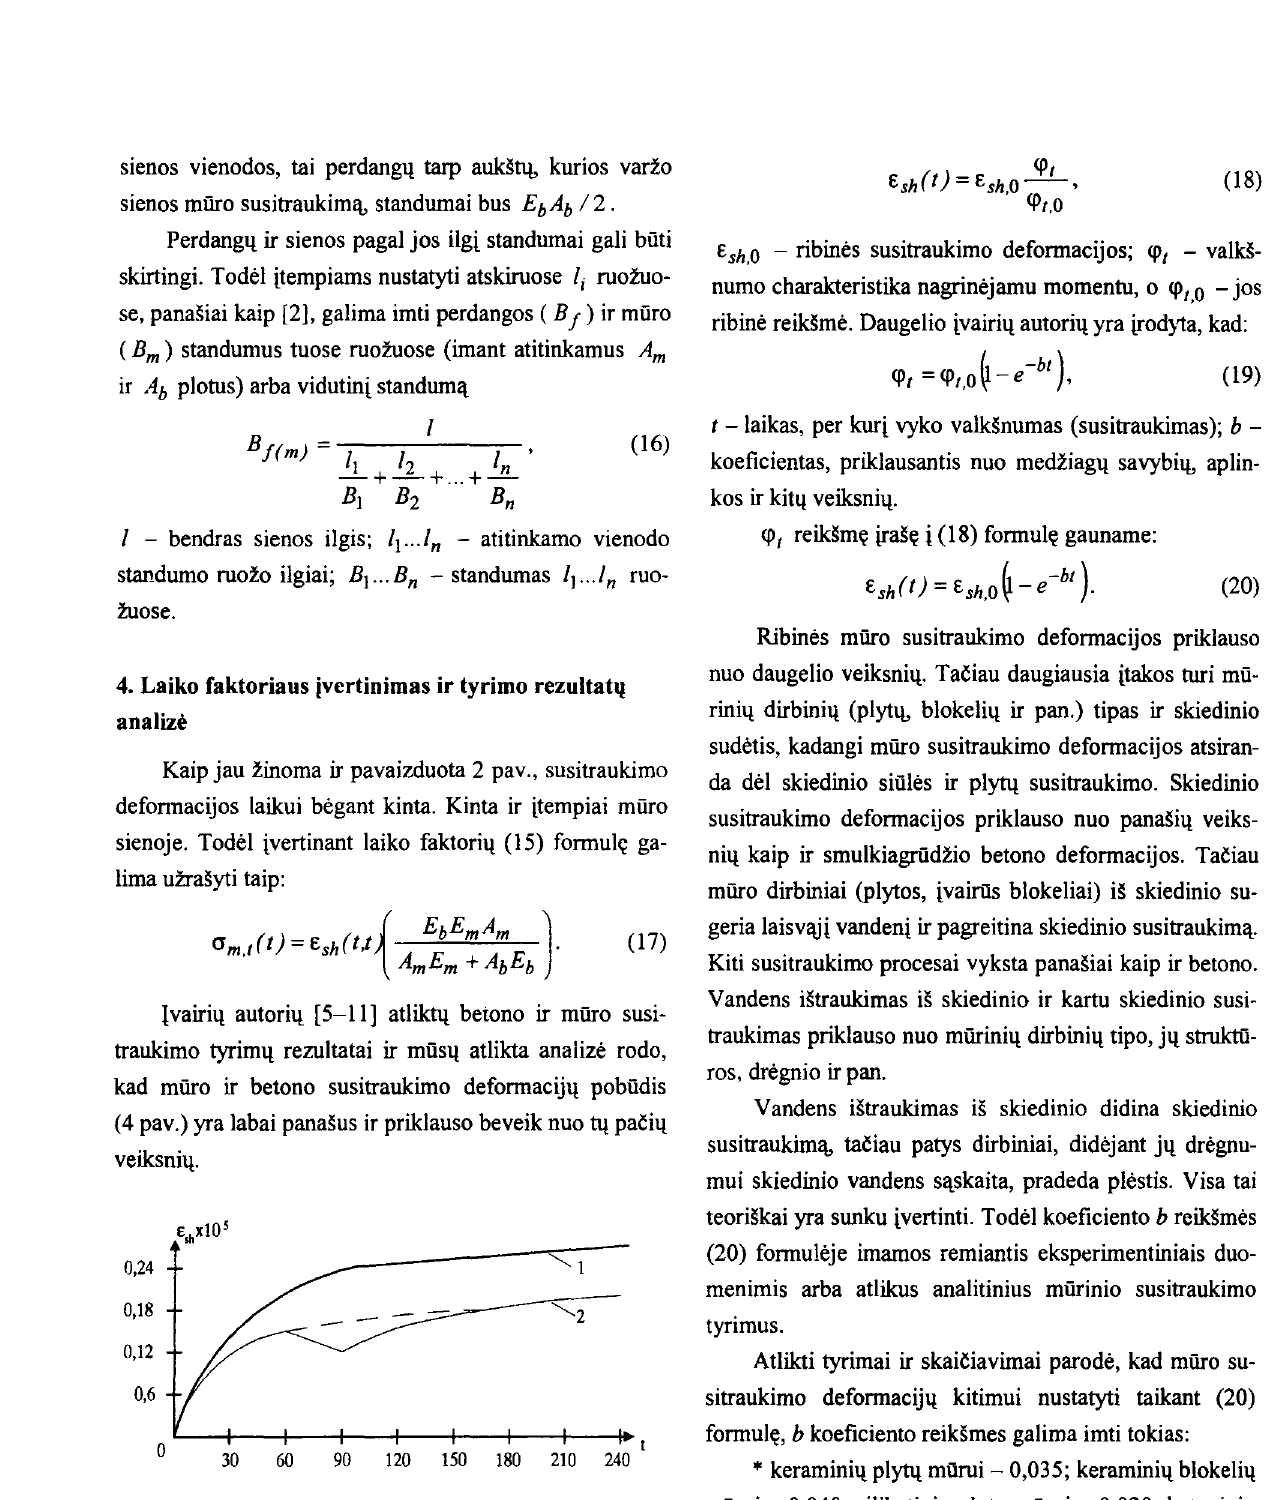
Fig 4. Comparison of development characteristics of ~ili­ cate brick masonry (1) [4] and concrete (2) shrinkage Antra vertus, yra agku, kad miire ir kituose sienos elementuose atsirad~ itempiai sukelia valksnumo defor macijas, kuriq kitirno pobildis taip pat panasus i susitrau kimo kitimo pobildi. Vadinasi, remiantis tyrimais [4,